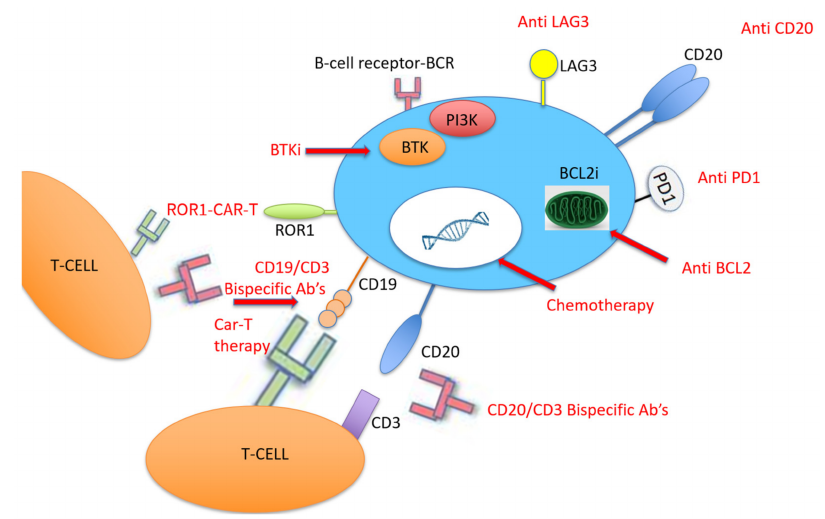
Figure 3. Target therapy and chemo-immunotherapy for the treatment of Richter transformation. Legend: Abs: antibodies; BCL2: B-cell lymphoma 2; BCL2i: B-cell lymphoma 2 inhibitor; BTK: Bruton tyrosine kinase; BTKi: Bruton tyrosine kinase inhibitor; CAR-T: chimeric antigen receptor T cell; LAG3: lymphocyte-activating 3; PD1: programmed death 1; PI3K: phosphoinositide 3-kinase;